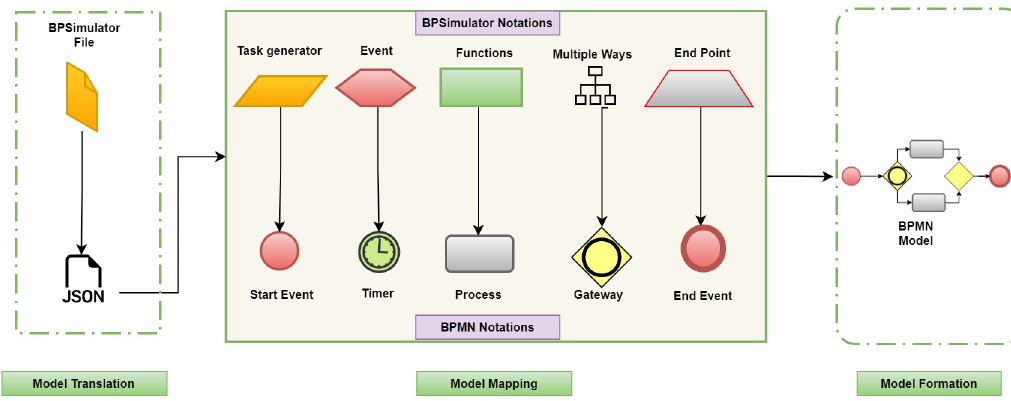
Fig 5. BPSimulator to BPMN convertor takes BPSimulator model file, maps the notation to BPMN and generates final model.